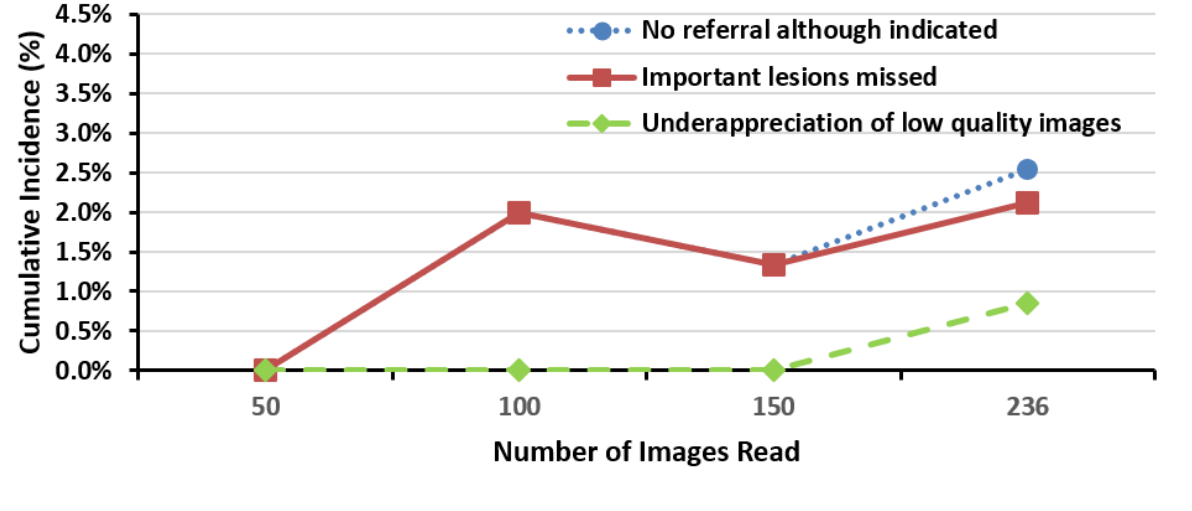
Figure 2. The cumulative incidence curve of misreadings for level 2 reader B image